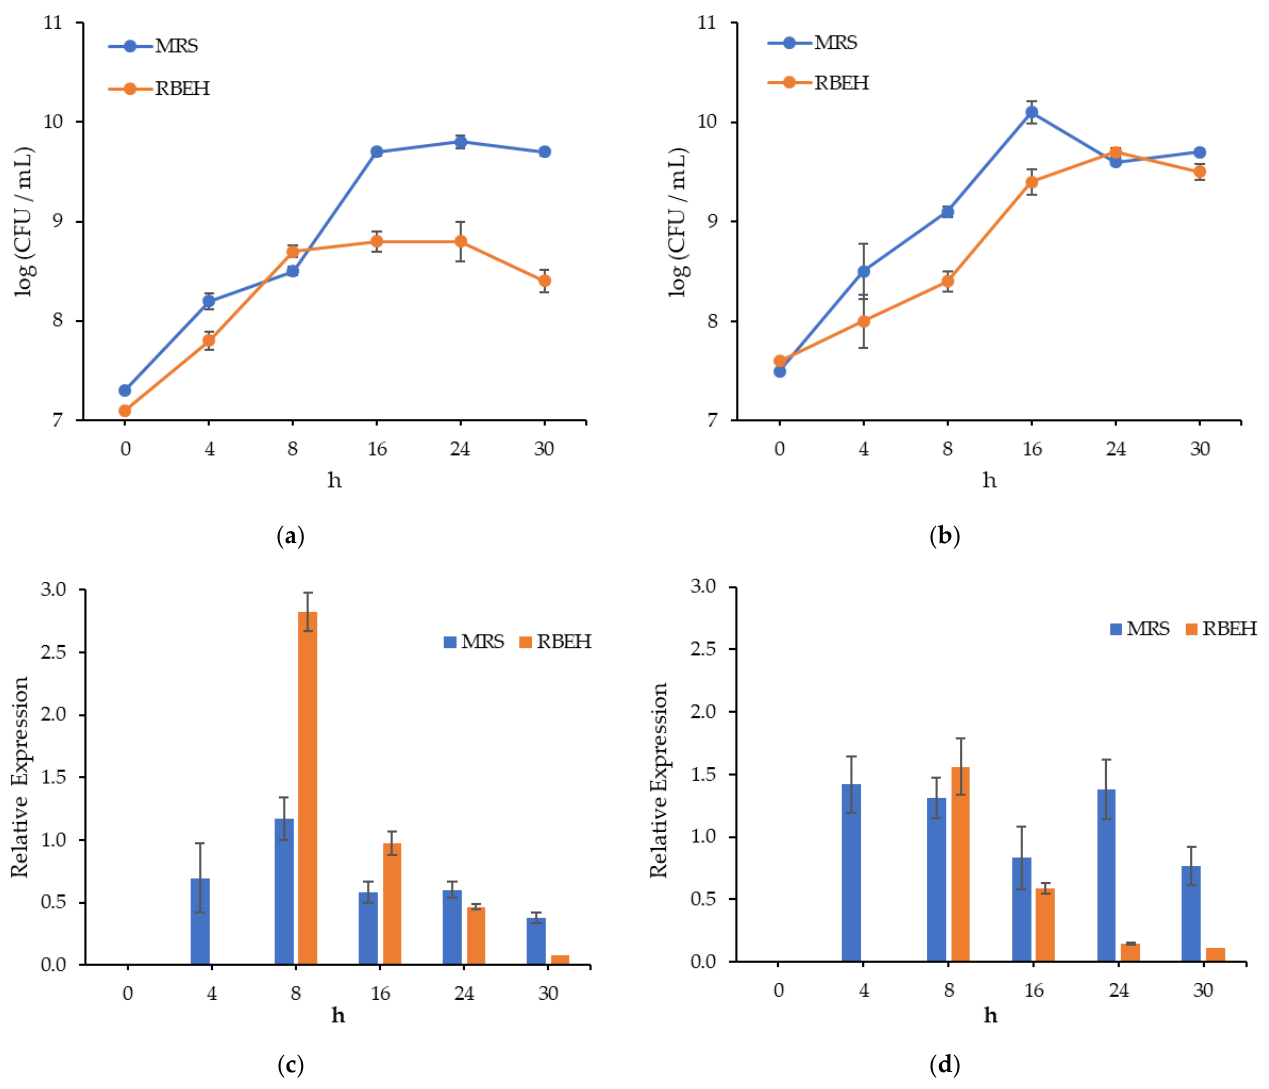
Figure 1. Growth dynamics of Lactobacillus paracasei B-11657 ( a ) and Lactobacillus salivarius B-2214 ( b ) and relative expression of bacteriocin gene in Lactobacillus paracasei B-11657 ( c ) and in Lactobacillus salivarius B-2214 ( d ) normalized to the expression of 16S rRNA gene during cultivation in MRS broth and RBEH.